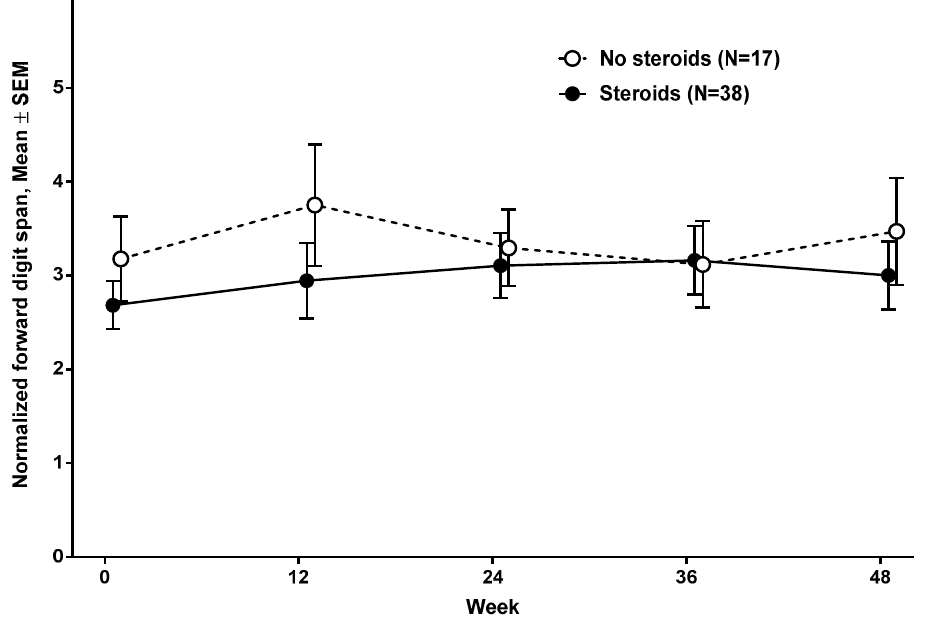
Figure 2. Forward digit span based on oral corticosteroid treatment.